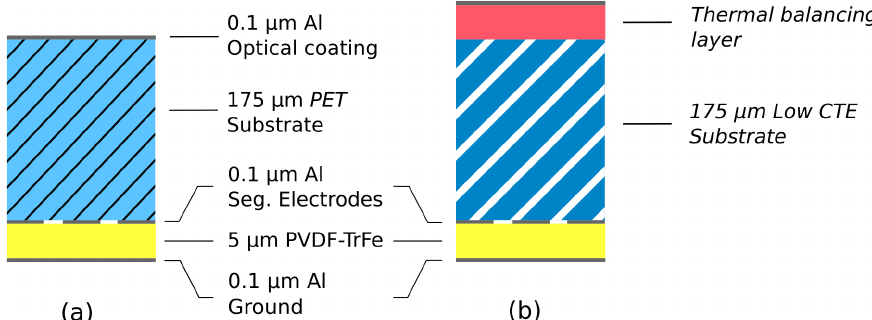
Figure 2. Layer configurations: ( a ) unimorph configuration used in earlier studies; ( b ) with a thermal balancing layer and low CTE